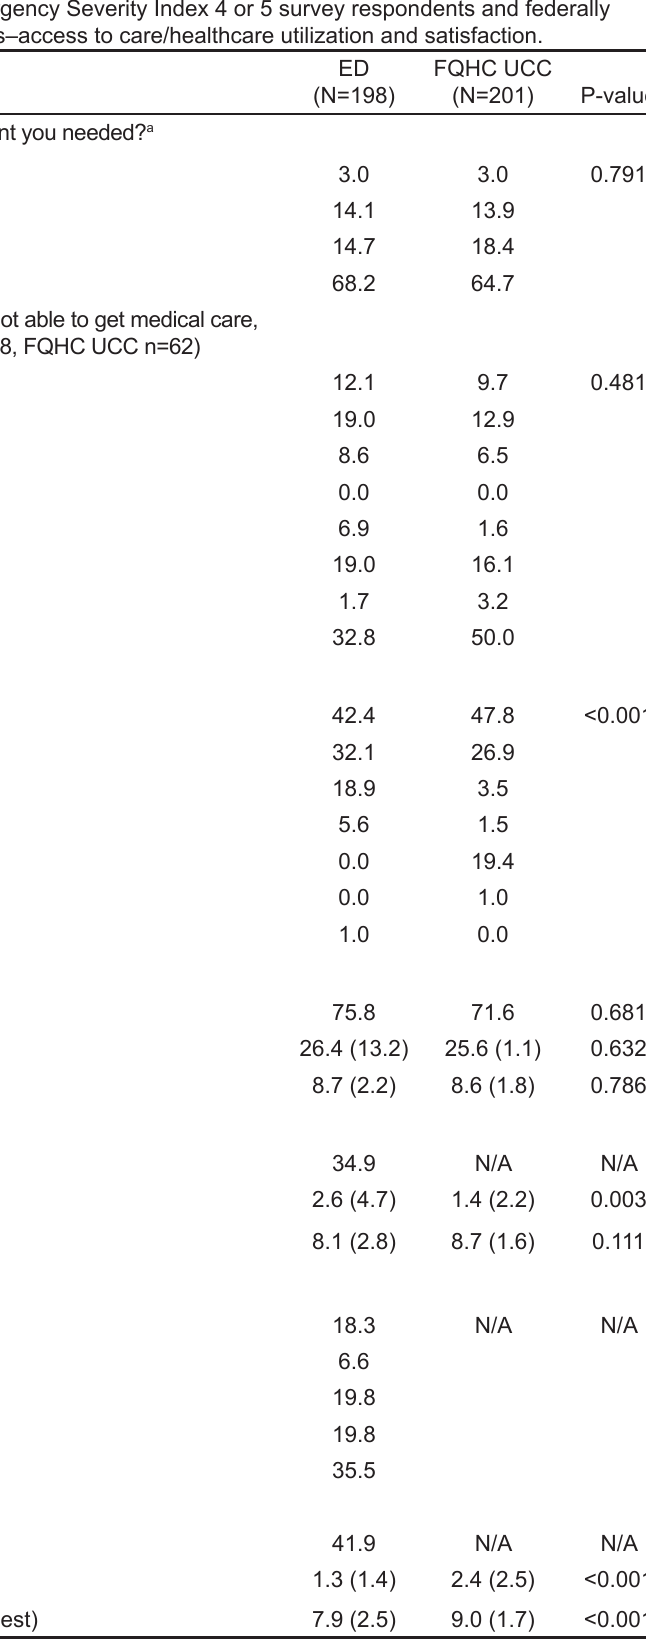
Table 2. Survey findings: Emergency department patients with Emergency Severity Index 4 or 5 survey respondents and